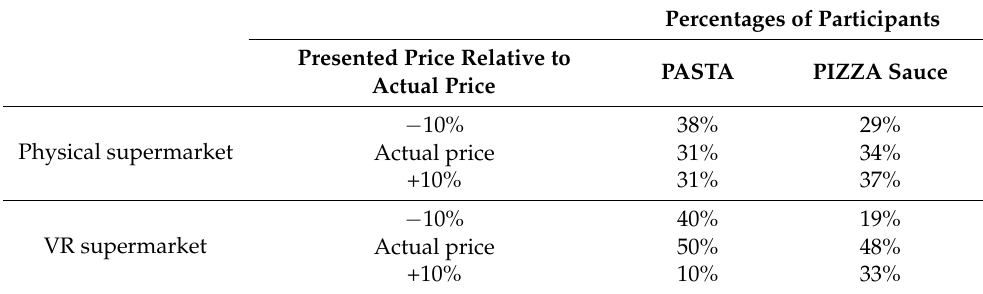
Table 2. Percentages of the participant’s ability to recognise the actual price paid for the products. Percentages of Participants Presented Price Relative to PASTA PIZZA Sauce Actual Price − 10% 38% Physical supermarket